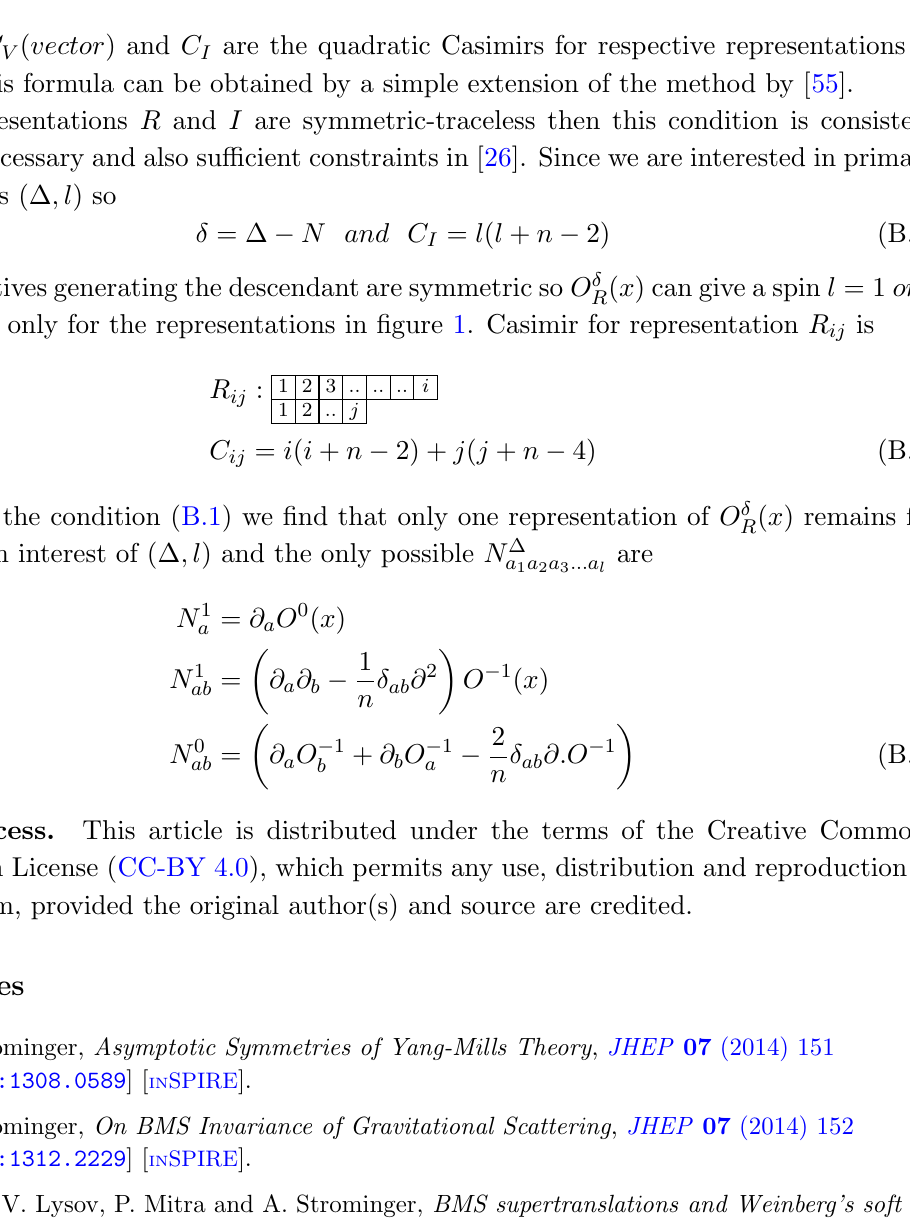
( x ) which can have a descendant of spin- l R